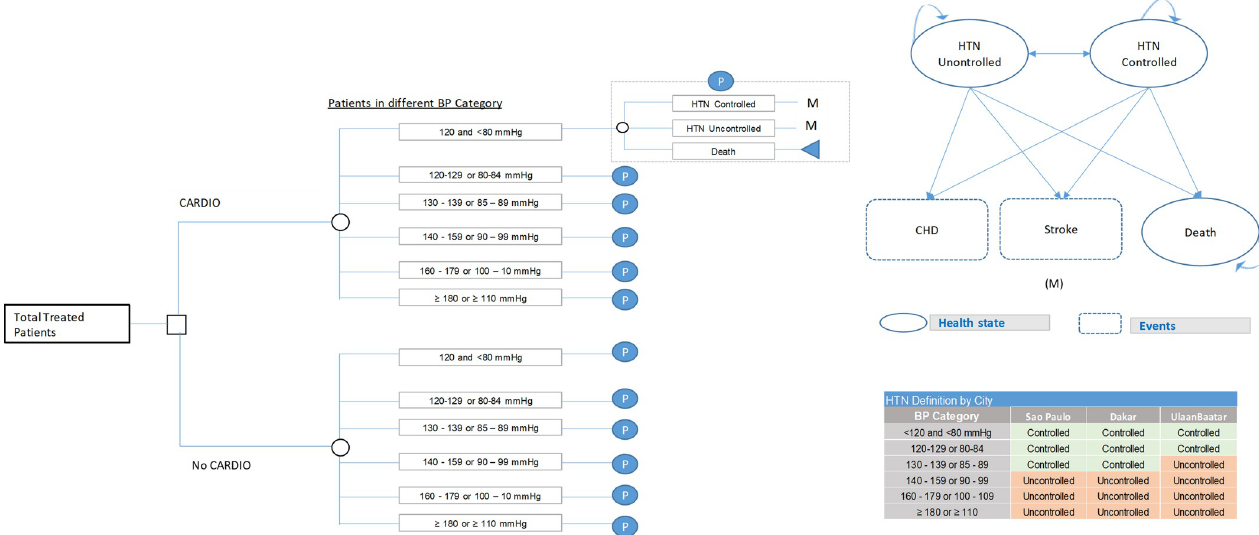
Fig 1. Schematic overview of the decision tree model for estimating CV events and deaths averted during the CARDIO implementation phase and of the Markov model used for a 10-year projection of population-level CV event rates. A. Decision tree model. The decision tree model was used to estimate CV events and deaths averted during the implementation phase. Patients were either included in the program (factual) or not (counterfactual). Within each arm, patients were assumed to fall within different blood pressure categories, according to a distribution matching the observed. Based on the BP, patients could achieve hypertension control or not, or die at fixed probabilities. B. Markov model. The Markov model assumes three states for patients: Controlled (BP controlled) or uncontrolled hypertension (BP uncontrolled), or death. The distribution of patients across the categories (M) at the beginning of the 10-year projection period was matched to the endpoint of the two-year implementation period (as estimated using the decision tree model). The model allowed for individual patients to remain in a state, transition between controlled or uncontrolled hypertension, or from either state to death. Controlled and uncontrolled patients could experience two health events (CHD event or stroke) at given